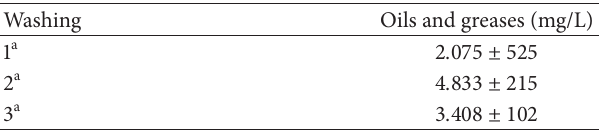
Table 2: Concentration of oils and greases obtained in the 1 a , 2 a , and 3 a wash waters.